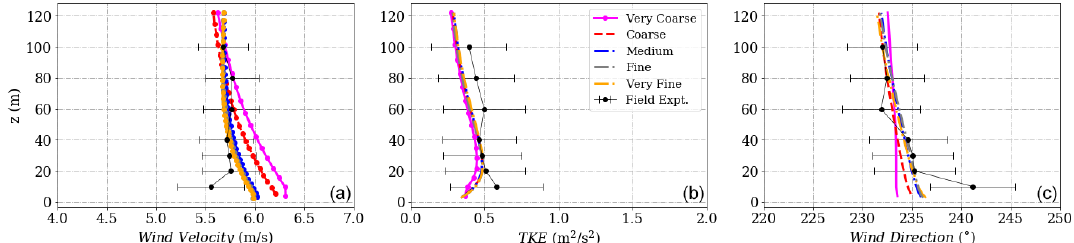
Figure A1. (a) Wind velocity magnitude, (b) wind direction and (c) turbulent kinetic energy tuned to reach calibration at height 573m corresponding to 100m at Tower 20 (tse04).